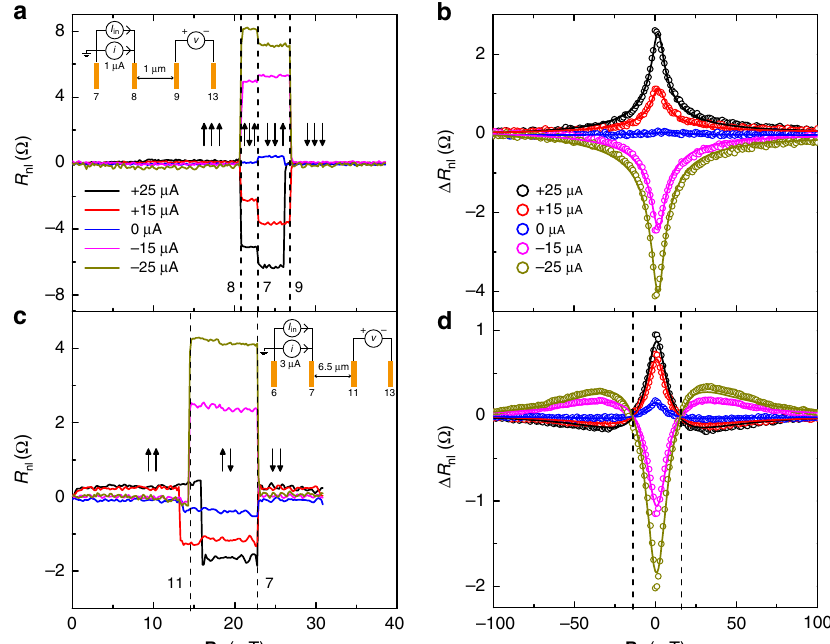
Fig. 2 Non-local spin-valve and Hanle measurements at different DC bias across the injector. a , c : Non-local differential spin-valve signal R nl ( = v / i ) as a function of the magnetic fi eld B y applied along the easy axes of the Co electrodes, for a short ( L = 1 μ m) a , and a long ( L = 6.5 μ m) c spin transport channel. An offset at zero fi eld is subtracted from each curve for a clear representation of the data. The vertical dashed lines correspond to the switching of the electrodes at their respective coercive fi elds. The switch of the outer detector 13 is not detectable as it is located far ( > 2 λ s ) from the nearest injector. The legend shows the applied injection DC current bias I in values. The up ( ↑ ) and down ( ↓ ) arrows represent the relative orientation of the electrode magnetizations. The three arrows in a correspond to the contacts 7, 8, and 9, and the two arrows in c correspond to the contacts 7 and 11, from left to right . The insets in a and c show the measurements schematics, injection AC current ( i ) and the DC current bias ( I in ), the respective contacts used for the spin current injection, and non-local differential voltage ( v ) detection. The differential spin signal in a due to spin injection through 8 is (cid:2) (cid:3) (cid:2) (cid:3) Δ R 8 (cid:2) 9 ¼ R """ (cid:2) R "#" ¼ R "" (cid:2) R "# = 2, and in c due to spin injection through 7 is Δ R 7 (cid:2) 11 = 2. b , d Non-local (differential) Hanle signal Δ R nl ( B z ) as a nl nl nl nl nl nl function of the magnetic fi eld B z . b , d shows Δ R nl measured for the short(long) channel, corresponding to the spin injector contact 8(7) and measured with the detector contact 9(11). The measured data are represented in circles and the solid lines represent the fi ts to the data. Hanle signals in b at different (cid:2) (cid:3) = 2. The two vertical dashed lines in d correspond to the fi elds where the Hanle signals cross injection bias values Δ R 8 (cid:2) 9 B z ð Þ ¼ R """ B z ð Þ (cid:2) R "#" B z ð Þ nl nl nl